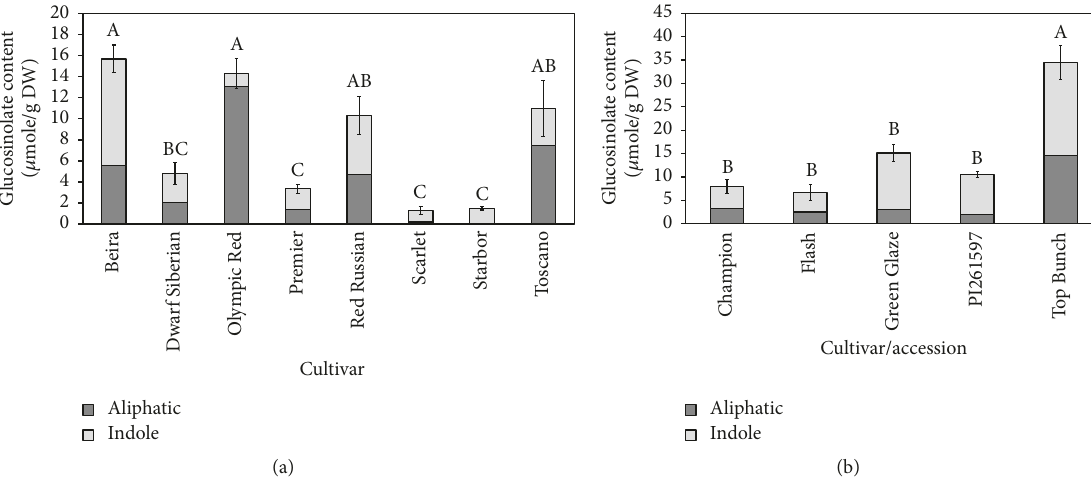
Figure 1: Glucosinolate composition of kale (a) and collard (b). Dark grey bars, aliphatic glucosinolates; light grey bars, indole glucosinolates. An unknown compound was included in the quantification of aliphatic glucosinolate. Data are shown as mean ± standard error for the total glucosinolate content ( 𝑛 = 3 ). Different letters mean significant difference in the total glucosinolate content among cultivars by Tukey’s HSD at p ≤